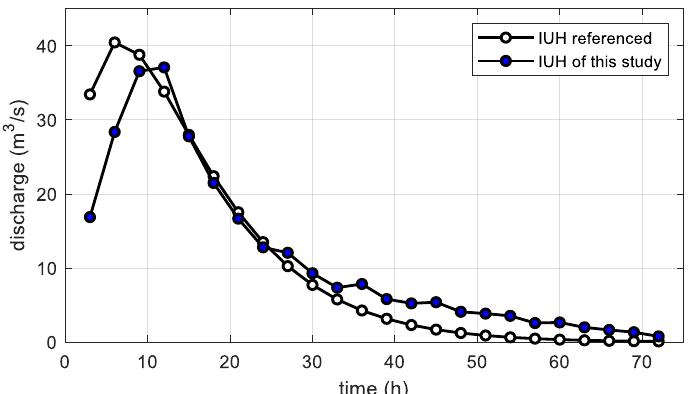
Figure 5. Comparison between IUHs derived by the Nash model and the proposed method for the selected storm.